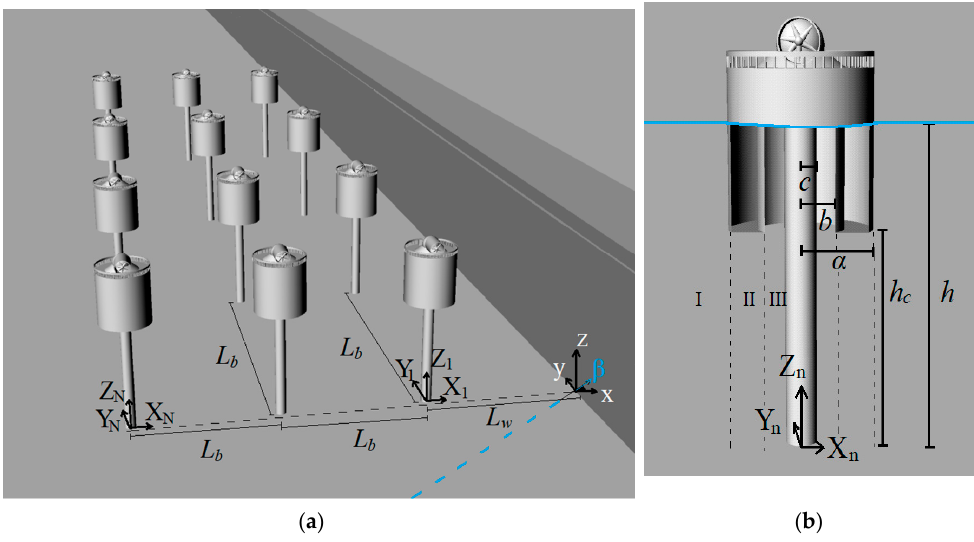
Figure 1. 3D representations of an OWC array in front of a breakwater: ( a ) array of N -OWCs in front of a breakwater; ( b ) schematic representation of the examined OWC, side view-xz.